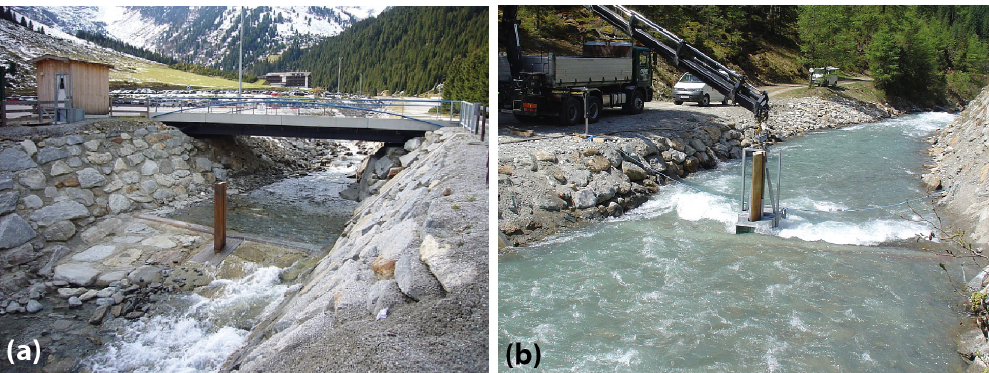
Figure 2. Monitoring sites equipped with a Swiss plate geophone system and a flow gauging station. (a) Ruetz, looking upstream onto the sill with the steel plates (28 October 2009). (b) Fischbach, looking downstream during a calibration measurement using the TIWAG basket sampler (27 May 2008). The steel–concrete pillar visible in both photos is used to guide the positioning of the basket sampler during the collection of bedload samples immediately downstream of the geophone